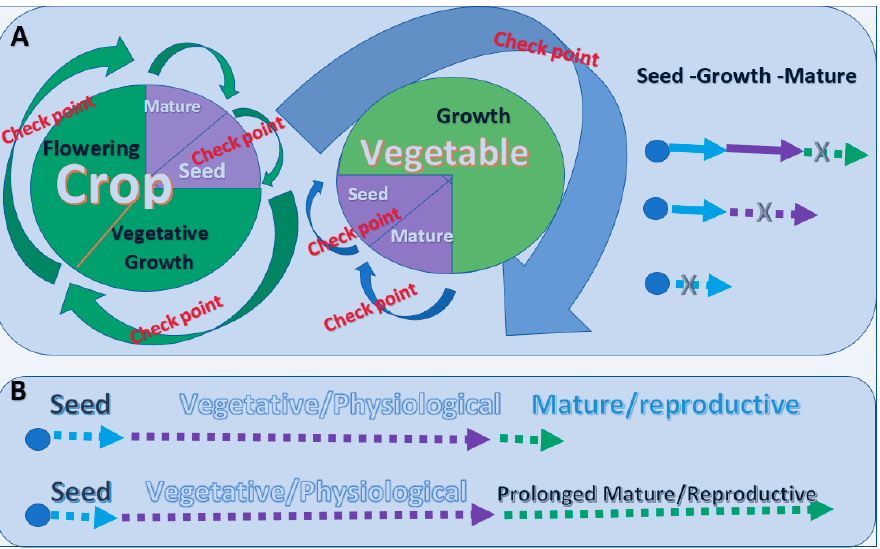
Figure 2. Life stages and lifespan of plants. ( A ) Stages of the life cycles of crops and vegetables. Stopping any stage during the growth of a plant will lead to its death. ( B ) Meaningful elongation of the stages of the life cycle to extend the lifespan of plants. A plant can increase its lifespan by increasing the period of vegetative growth. A vegetable can increase its lifespan by having a long period of